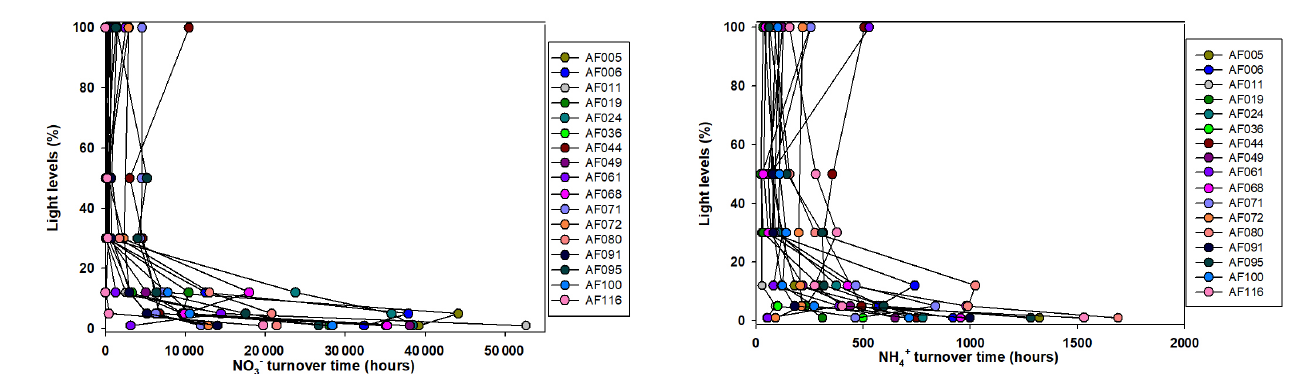
Figure 6. Turnover times for the NO − toplankton are the only consumers, in the sampling locations in the Arctic Ocean.